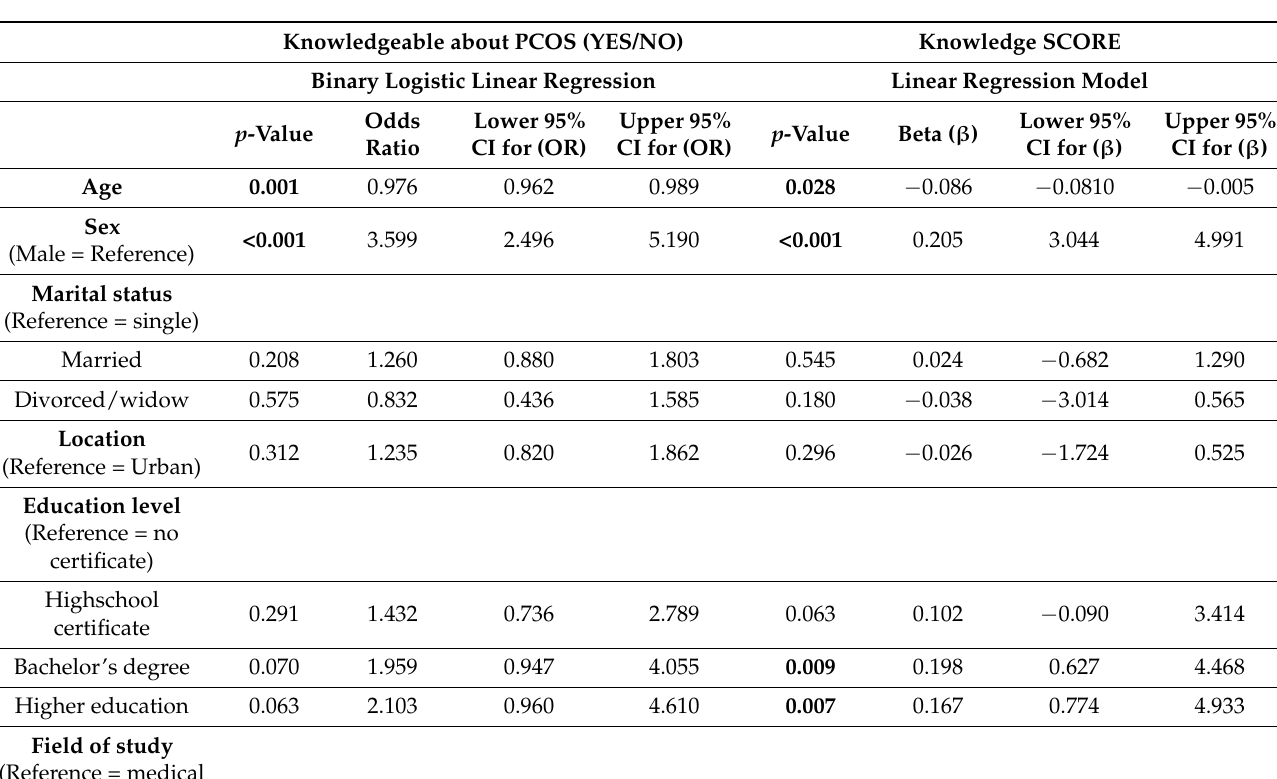
Table 4. Predictors of PCOS